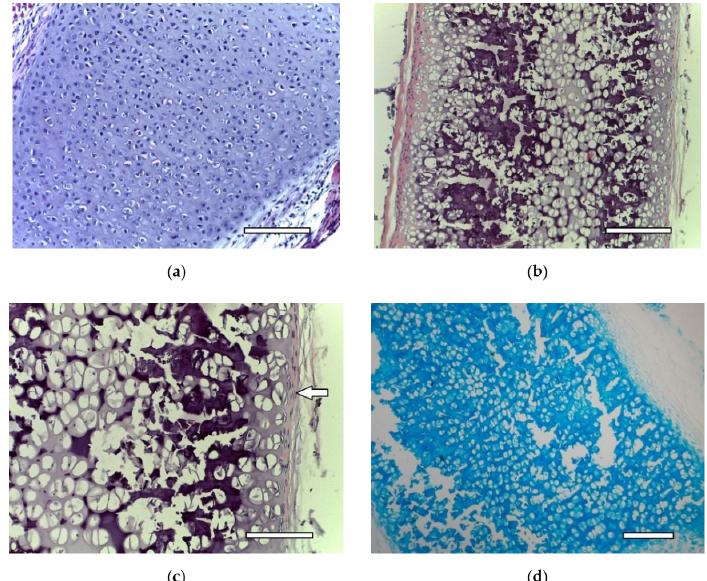
Figure 2. Costal rat cartilage. ( a ) native cartilage, staining with hematoxylin and eosin, objective lens × 20, scale bar—100 µ m; ( b ) decellularized sample, staining with hematoxylin and eosin, objective lens × 10, scale bar—200 µ m; ( c ) decellularized sample, staining with hematoxylin and eosin, objective lens × 20, scale bar—100 µ m. Perichondrium cells are shown by arrows; ( d ) decellularized sample, staining with alcian blue, objective lens × 10, scale bar—200 µ m.